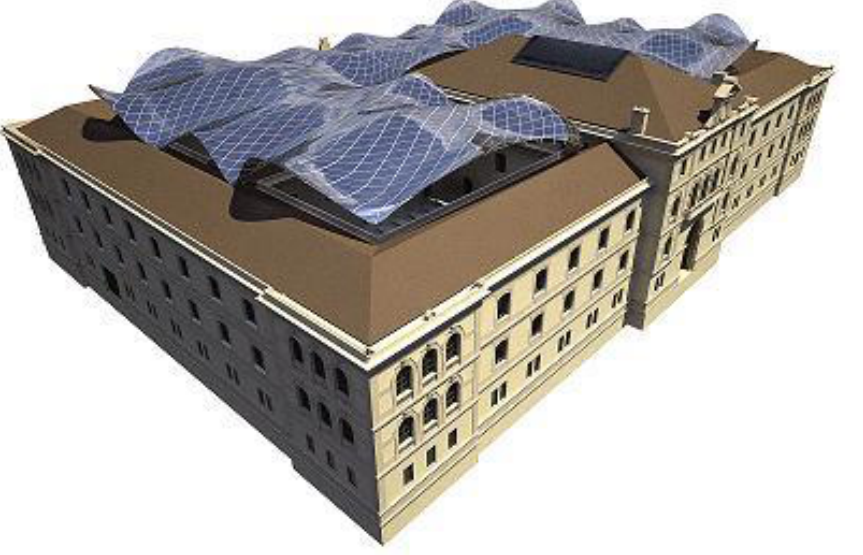
Figure 16. View of the retrofitted main building, a project by archs. Pablo Rico Perez and J. M Cab- eza-Lainez.